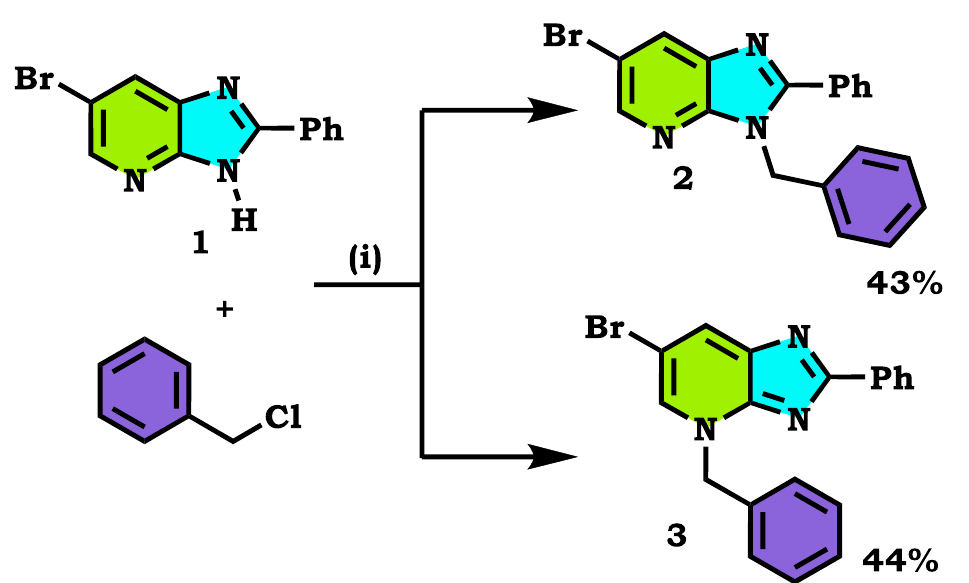
Molecules 2023 , 28 , x FOR PEER